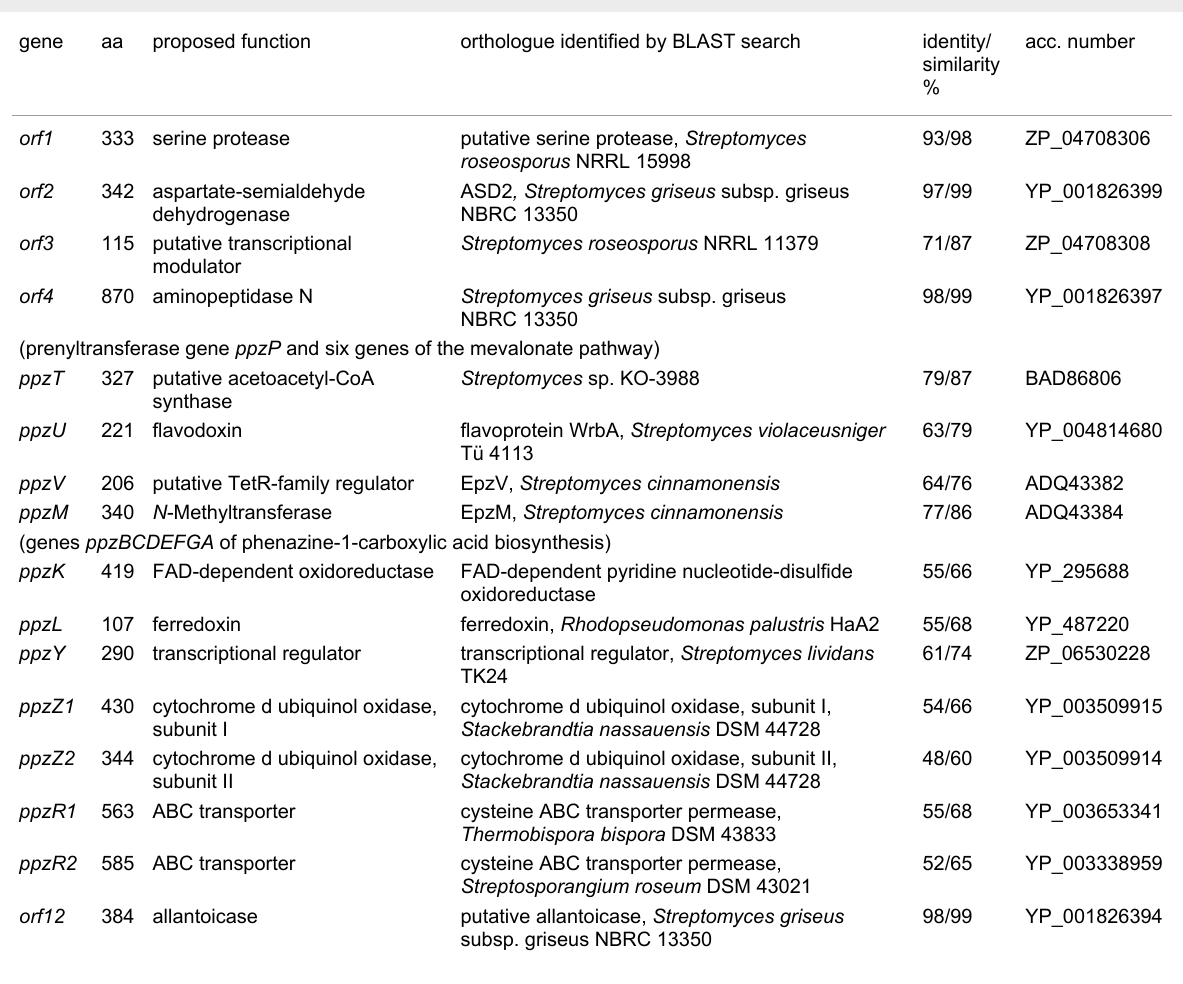
Table 1: Genes investigated in this study.